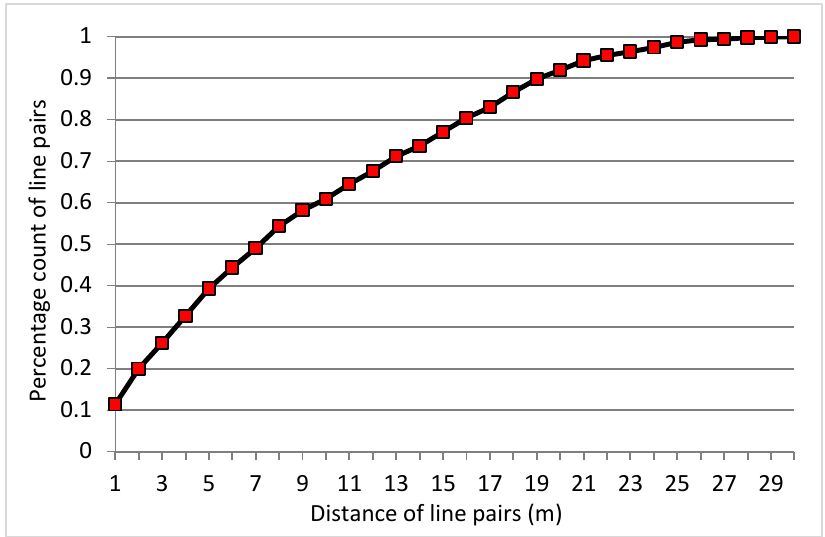
Figure 3. Histogram of the distances between the reference and OSM road